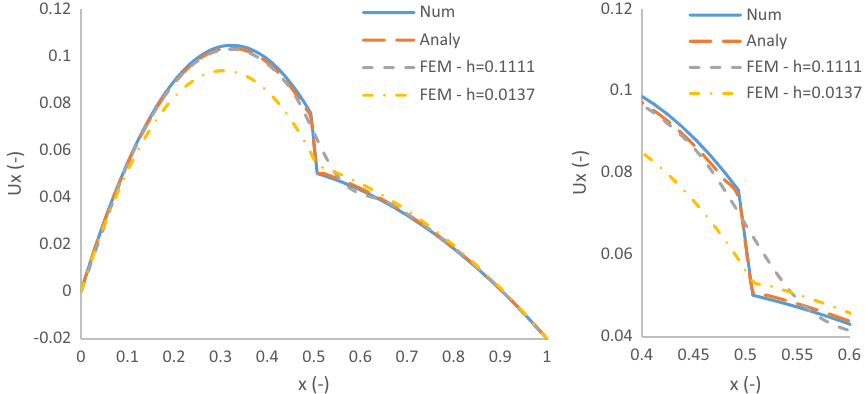
Fig. 18 Comparison of the numerical solution to the analytical solution and predictions from a standard FEM (left) Full solution profile and (right) close up of solution profile near the